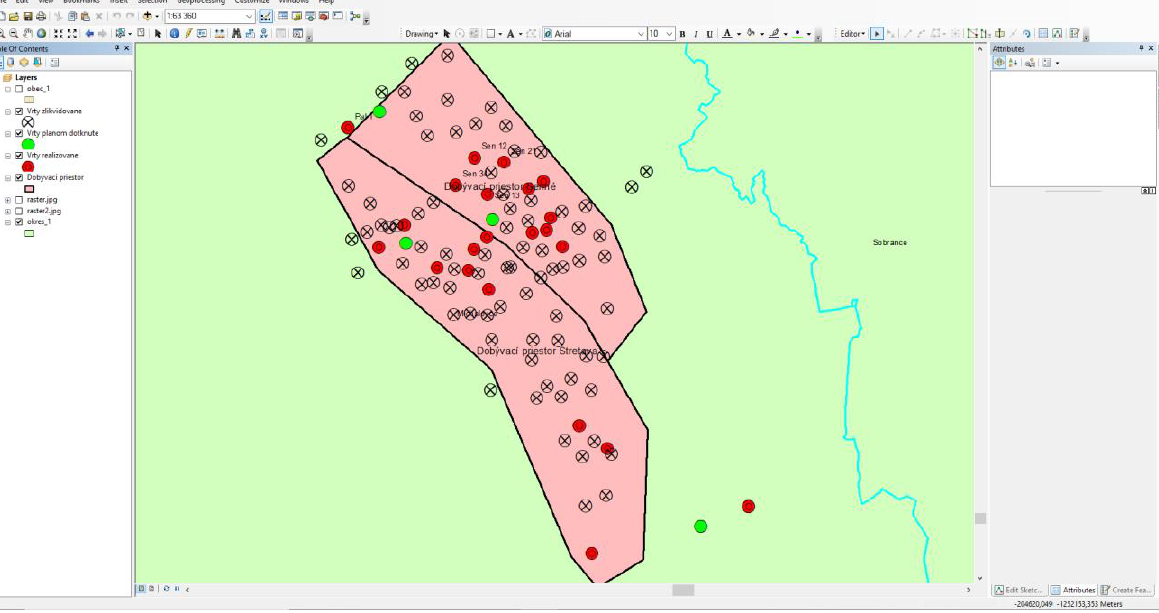
Figure 6. Placement of the wells in mining areas, (source: elaborated by authors). The last step was to fill the individual wells with all the basic technical information and well parameters. This was done using the top bar via the Start Editing function as shown in Figure 7.